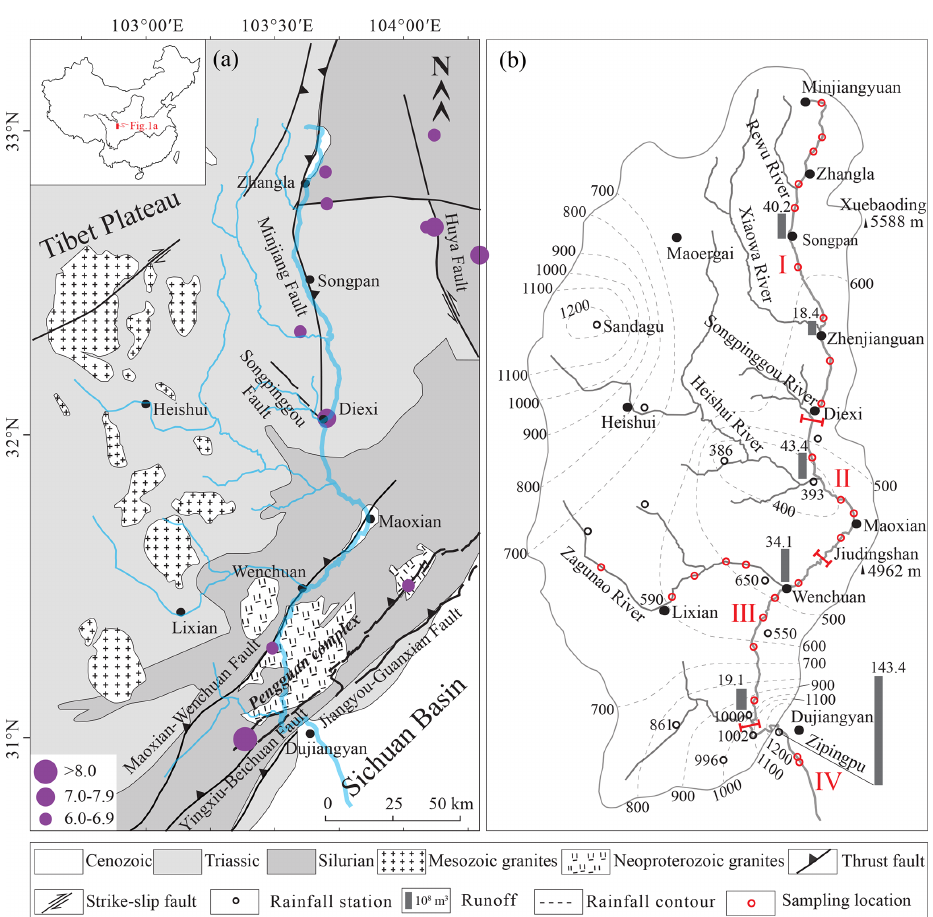
Figure 1. (a) Geological map and (b) precipitation distribution (Ding et al., 2014) for the upper Min River Basin. Seismic data are from the China Earthquake Data Center (http://www.ceic.ac.cn/history, last access: 9 June